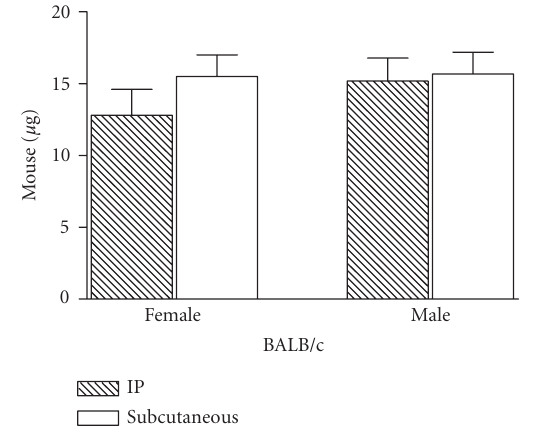
Figure 2: E ff ect of CSV on body weight. Groups of female mice from BALB/c strain, with di ff erent body weights, were injected in- traperitoneally and/or subcutaneously with di ff erent amounts of CSV. Deaths occurring during 24h were recorded and the LD 50 value was calculated. The experiment was repeated twice and each point represents the values of pooled sera from 5 animals